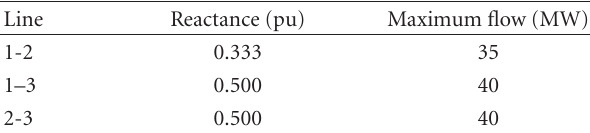
Table 1: Lines data of the 3 buses